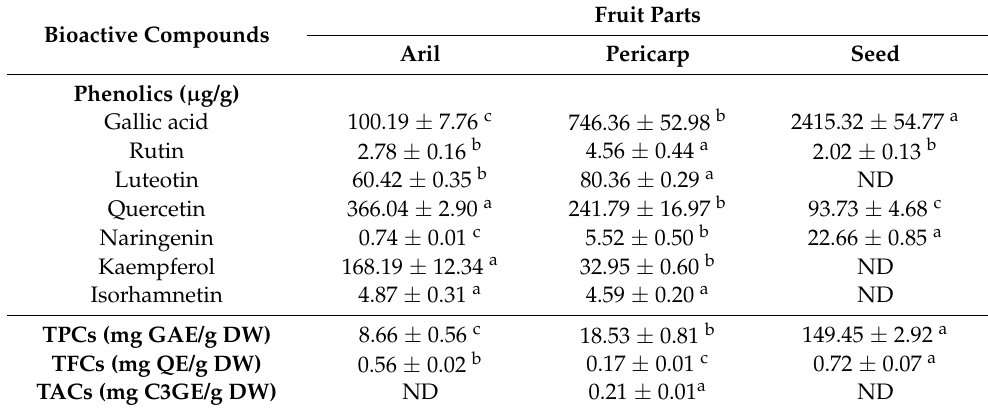
Table 4. Phenolic profiles of different fruit parts of Nephelium hypoleucum Kurz. Fruit Parts Bioactive Compounds Aril Pericarp Seed Phenolics ( µ g/g) Gallic acid